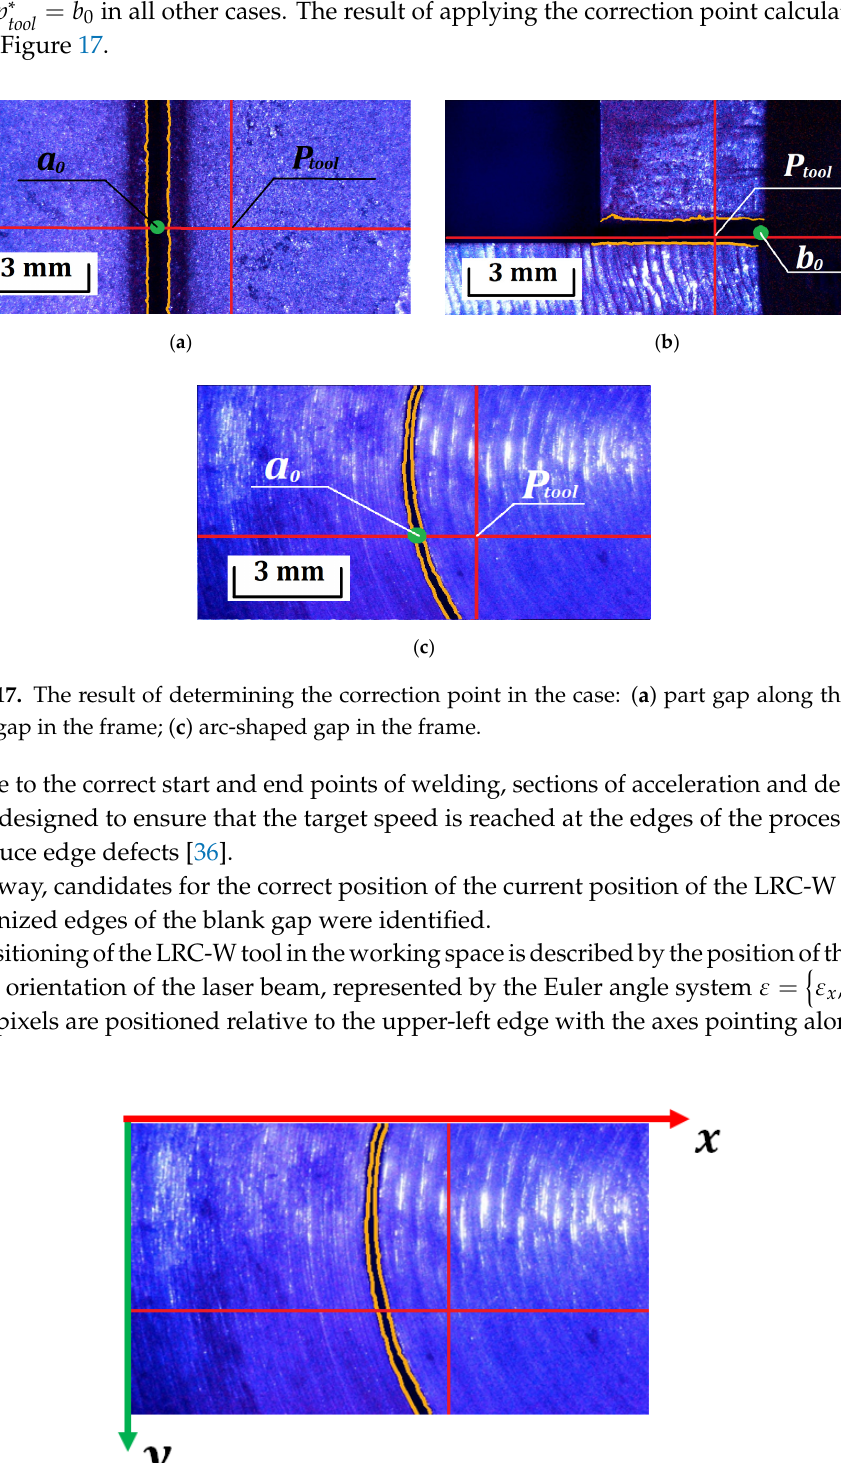
Figure 18. Image coordinate system.